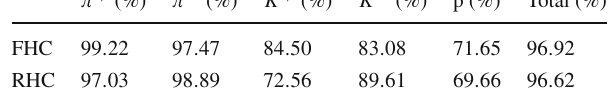
spaceforthereversehorncurrentconfiguration.TheNA61/SHINEcov- erage from the 2010 replica target measurement is overlaid on top of the